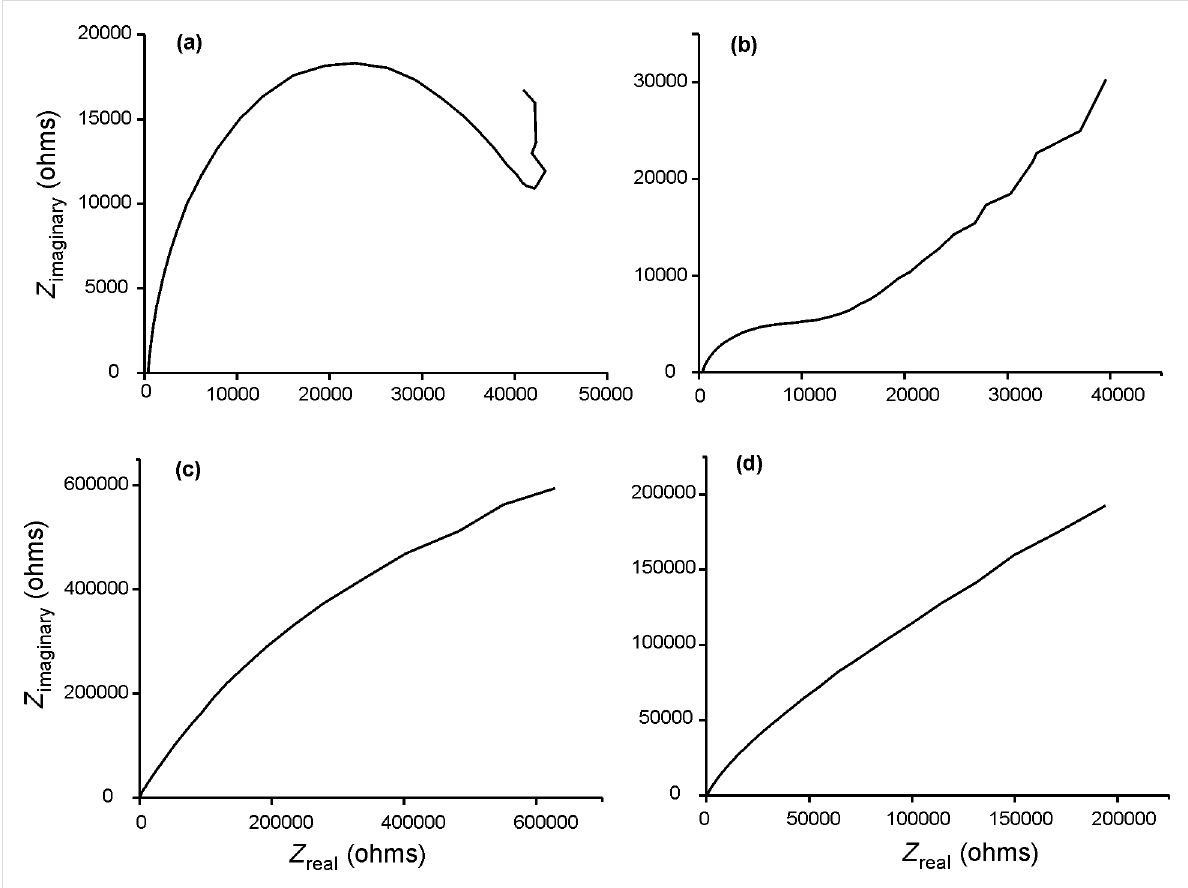
Figure 3: Nyquist plot of films deposited onto Pt registered in 0.1 mol/L KCl. Frequency swept from 105 to 0.1 Hz (a) Ppy-CA Pt ; (b) Ppy/AuNP-T-CA Pt ; (c) Ppy/AuNP-C-CA Pt ; (d) Ppy/AuNP-C-CP Pt